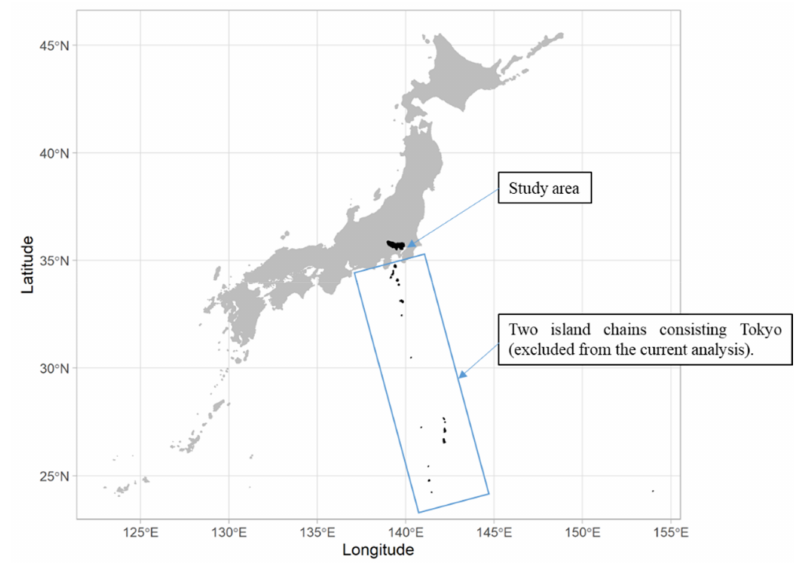
Figure 2. Location of study